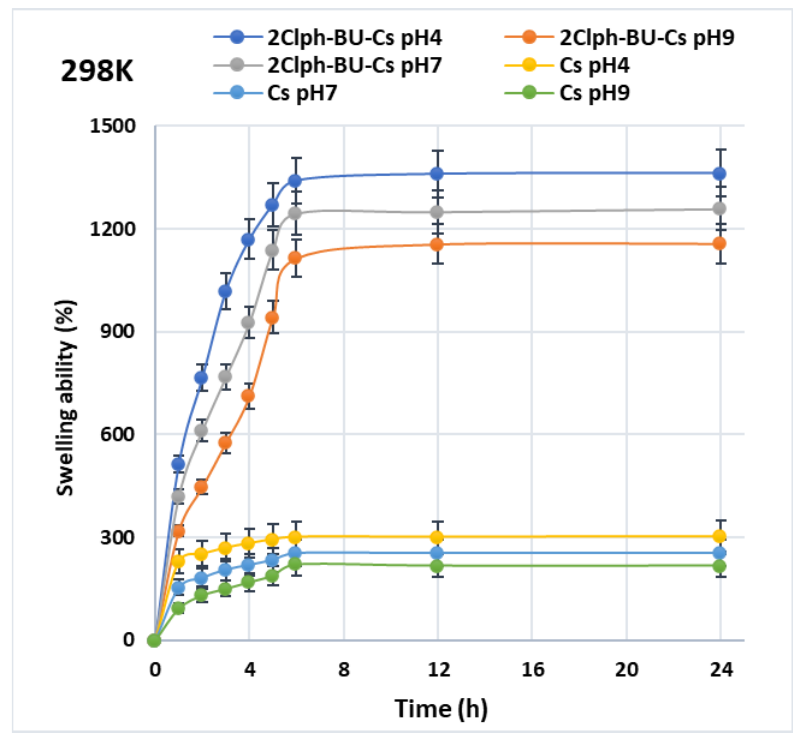
Figure 7. Swelling ability of Cs and 2Clph-BU-Cs hydrogel in pH 4, 7, and 9 at T= 298 K.